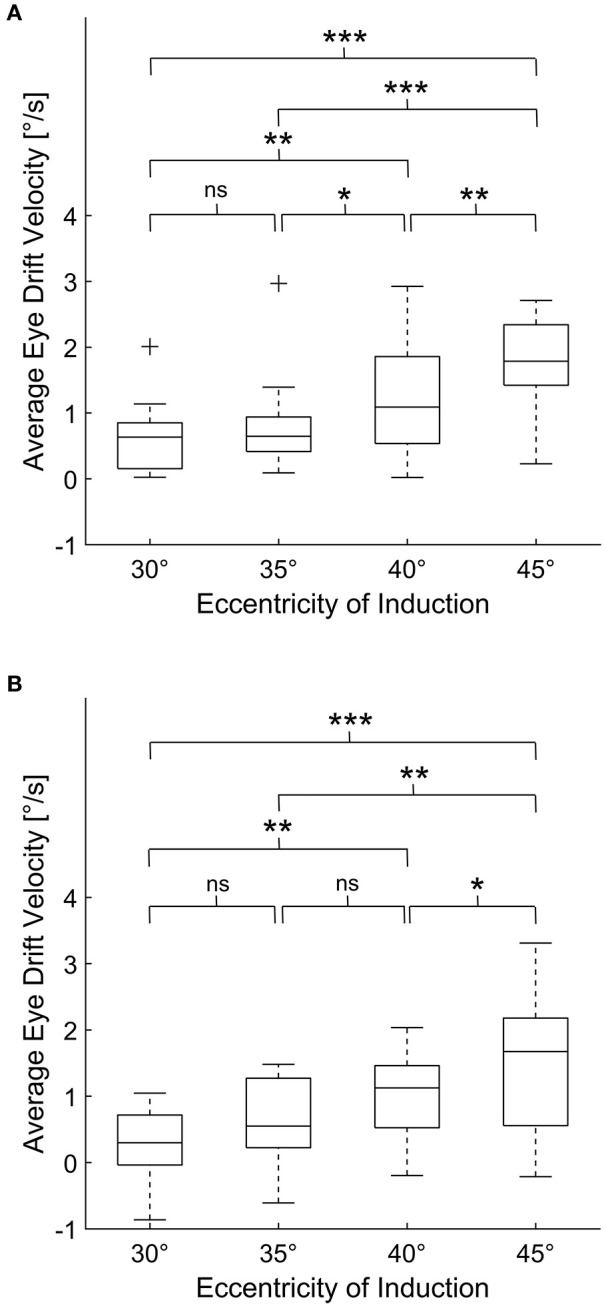
Average eye drift velocities of all subjects during 30 s of eccentric gaze (A) and after subsequent return to primary position (B). For each box, the central line indicates the median value. The bottom and top of the box indicate the 25th and 75th percentiles, while the whiskers extend to the most extreme data points that are not considered outliers. The outliers are marked with “+.” One-way repeated measures ANOVA demonstrated statistically significant changes in eye drift velocity depending on the eccentricity of the induction phase for both eye drift during and after 30 s of eccentric gaze. The p-values, corrected for multiple comparison using Bonferroni adjustment, are shown in each panel (ns for p > 0.05, * for p ≤ 0.05, ** for p ≤ 0.01, *** for p ≤ 0.001).